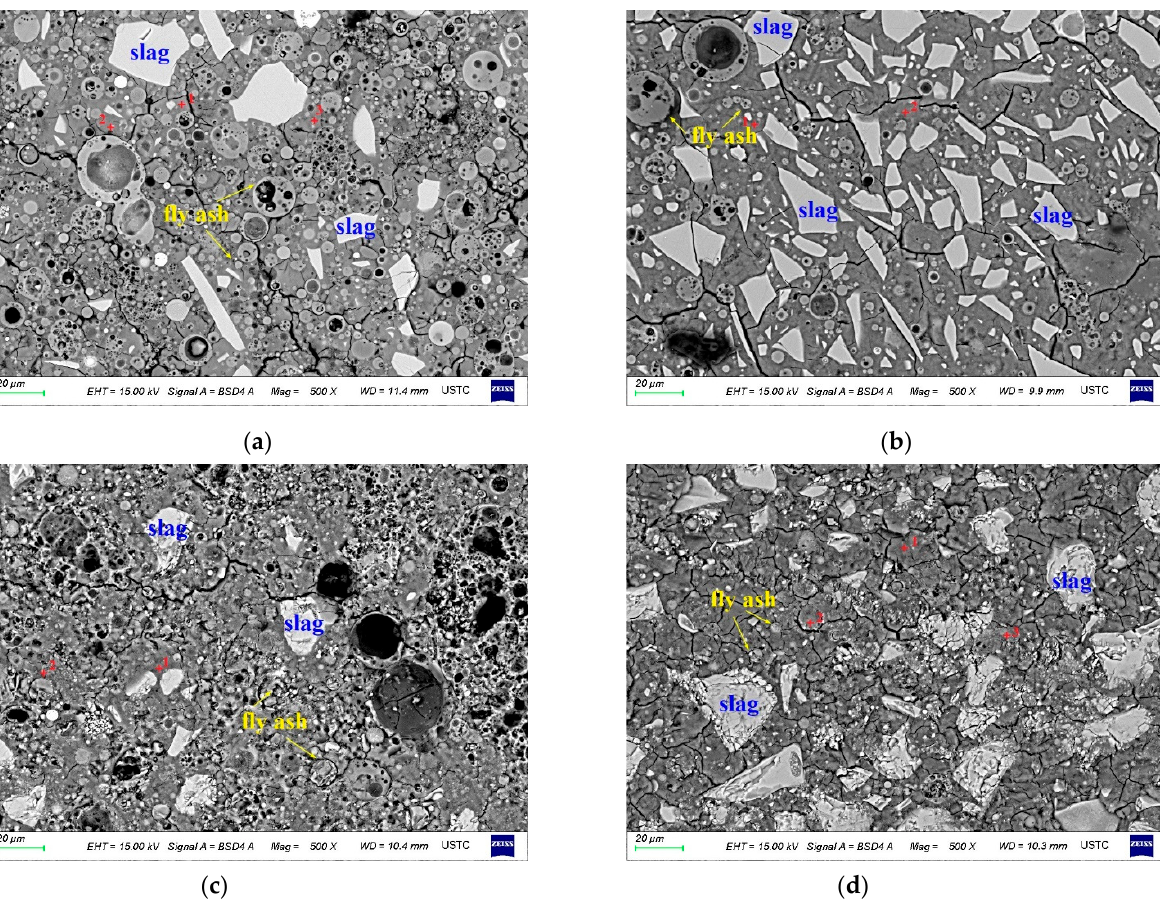
Figure 11. Backscattering morphology of B5 and B7 under dry- and water-saturation-curing condi- tions. ( a ) D-B5. ( b ) D-B7. ( c ) W-B5. ( d ) Table 5. Average Ca/Si ratio of geopolymer by EDS analysis.